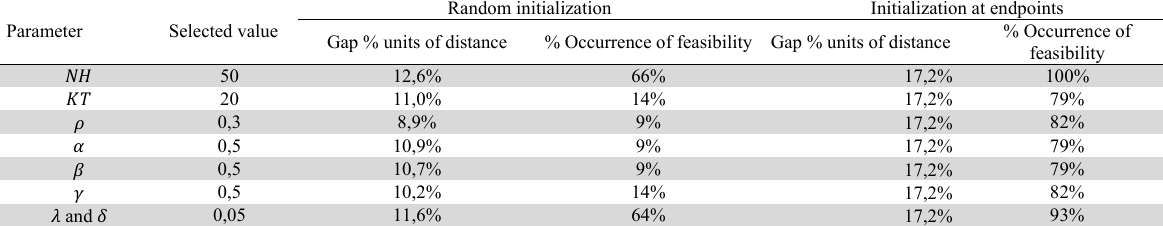
Performance of values selected by the